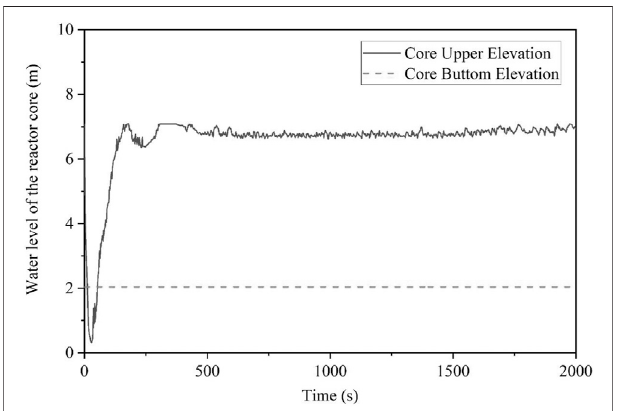
FIGURE 10 | Double-ended CL LBLOCA HET injection mass fl ow